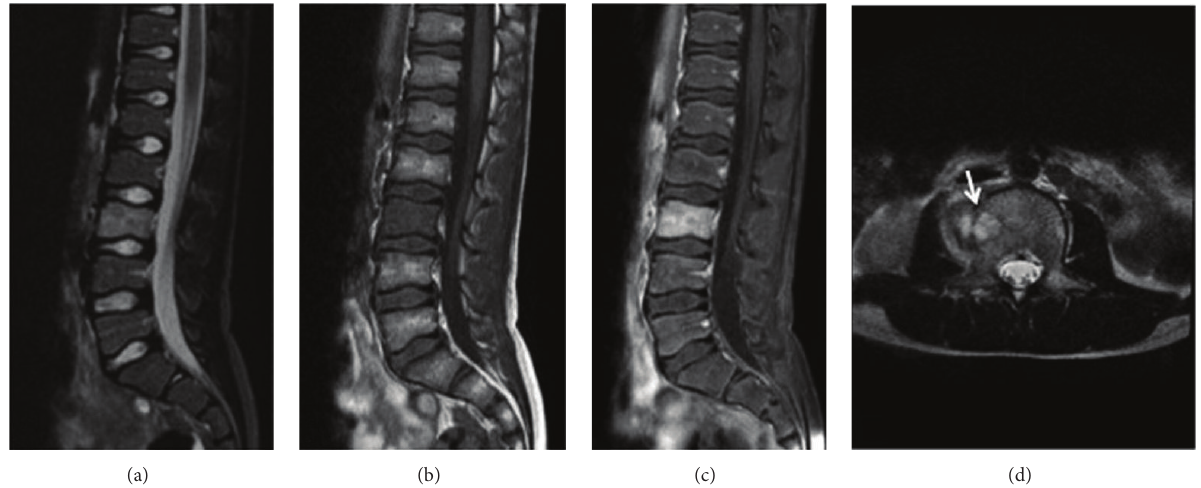
Figure 2: MRI scan of the lumbar spine. Sagittal spin-echo T2 weighted MR image (a) and T1 weighted MR image (b); contrast-enhanced T1 weighted image with fat saturation (c) only reveal edematous changes of the vertebral body of L3 with integrity of the L3-L4 disk. Axial Short tau inversion recovery MR image (d) shows vertebral abscess with extension to the paravertebral soft tissues (white arrow).